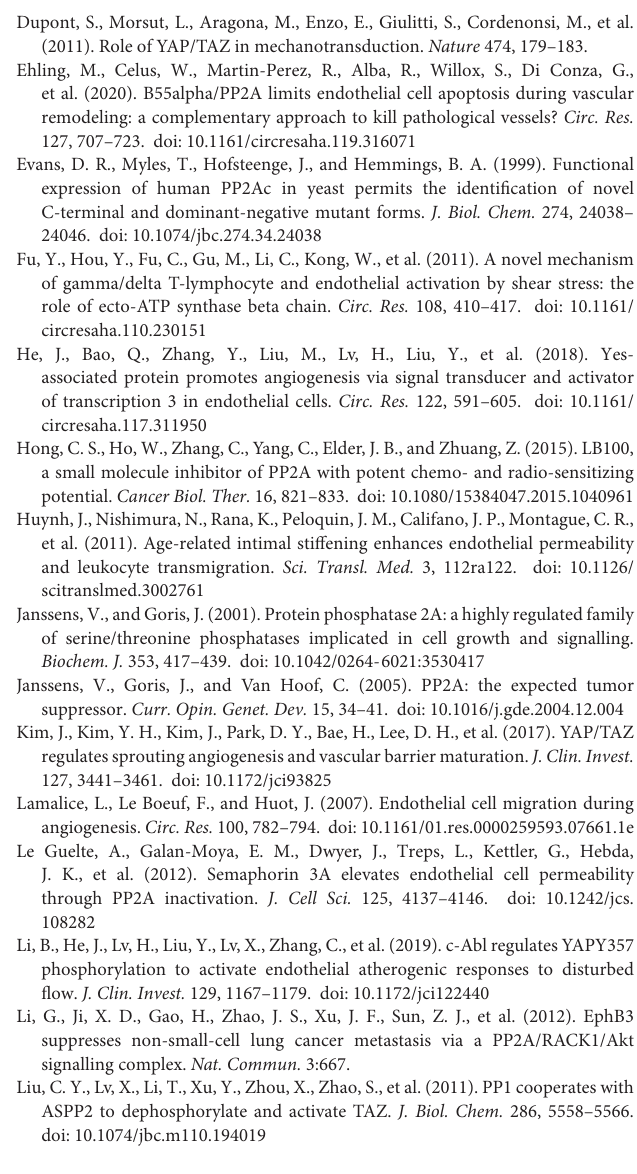
Supplementary Figure 1 | PP2A activity is required for EC cytoskeleton change and sprouting. (A) Representative images of HUVECs stained with Phalloidin (actin) showing that lamellipodia formation upon VEGF (50 ng/mL for 30 min) treatment in WT-PP2Ac or DN-PP2Ac expressing HUVECs. (B) Quantification of the number of HUVECs with lamellipodia of (A) . Cells in nine random fields of view ( ≈ 120 cells) were quantified. (C) Representative images of WT-PP2Ac or DN–PP2Ac expressing HUVECs seeded on soft (0.2 kpa) and stiff (20 kpa) hydrogels stained for Phalloidin (actin). (D,E) Quantification of individual cell area and circularity in (C) . A, area; P, perimeter. Cells in 10 random fields of view ( ≈ 50 cells per condition) were quantified. (F) Representative images of mice aortic rings treated with vehicle (Ctrl) or LB100 (4 µ M). (G) Quantification of microvascular